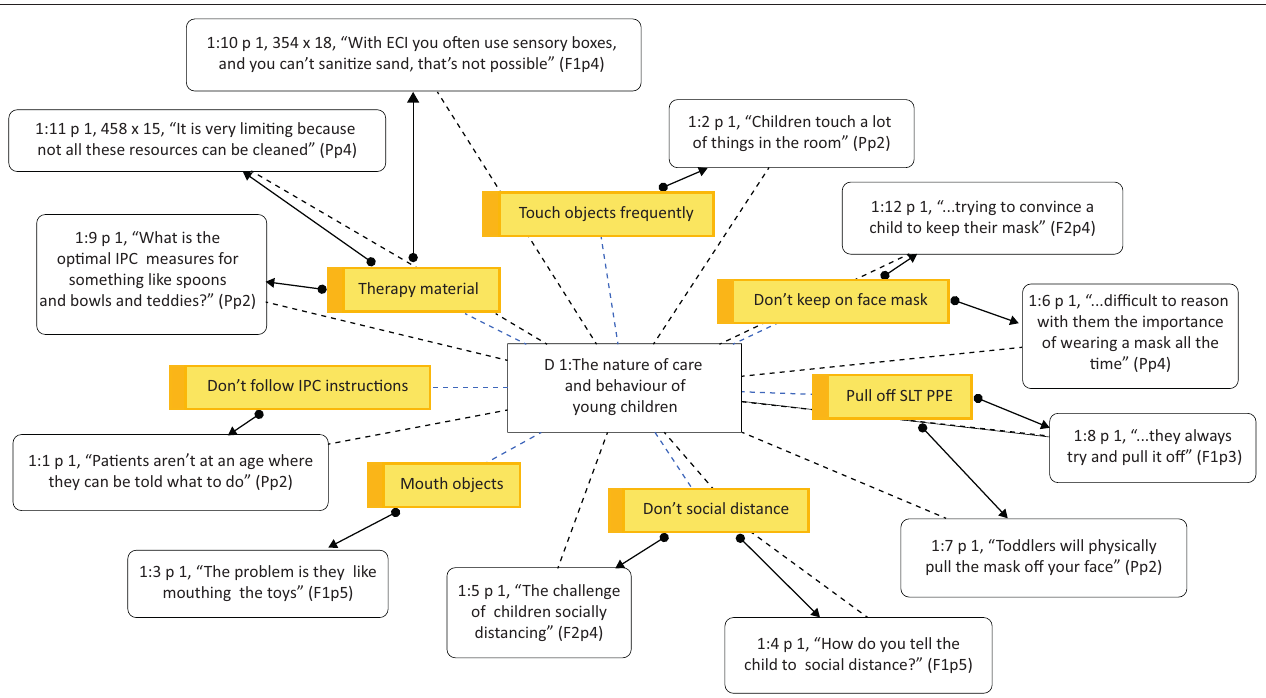
FIGURE 2: Organic network showing the nature of care and behaviour of young children in response to infection prevention and control measures within early communication intervention as reported in the focus group discussions, generated by ATLAS.ti version